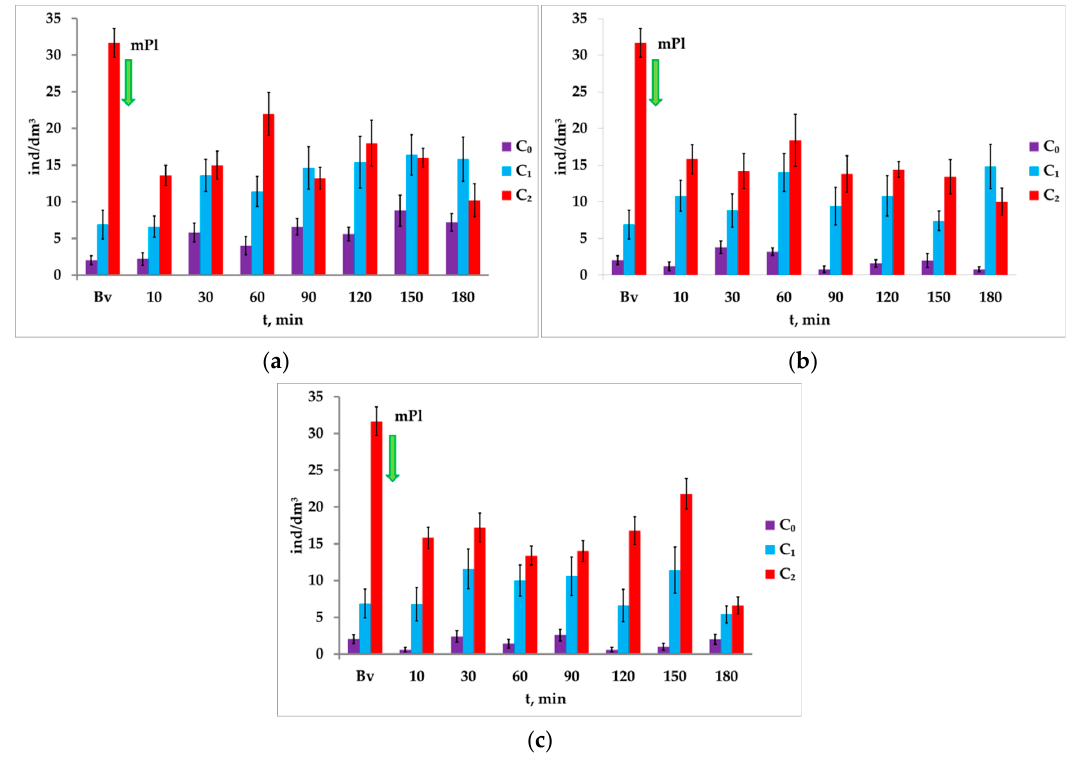
Figure 10. Response of A. salina to paired photostimulation in the presence of microplastics at the concentration of 0.05 mg/dm 3 ( a ), 0.1 mg/dm 3 ( b ), 1.0 mg/dm 3 ( c ), C 0 —average concentration of crustaceans before photostimulation; C 1 —average concentration of crustaceans at photostimulation with intensity I 1 (1150 lx); C 2 —average concentration of crustaceans at photostimulation with intensity I 2 (3450 lx) ; Bv—background value; Green arrow—pollution.